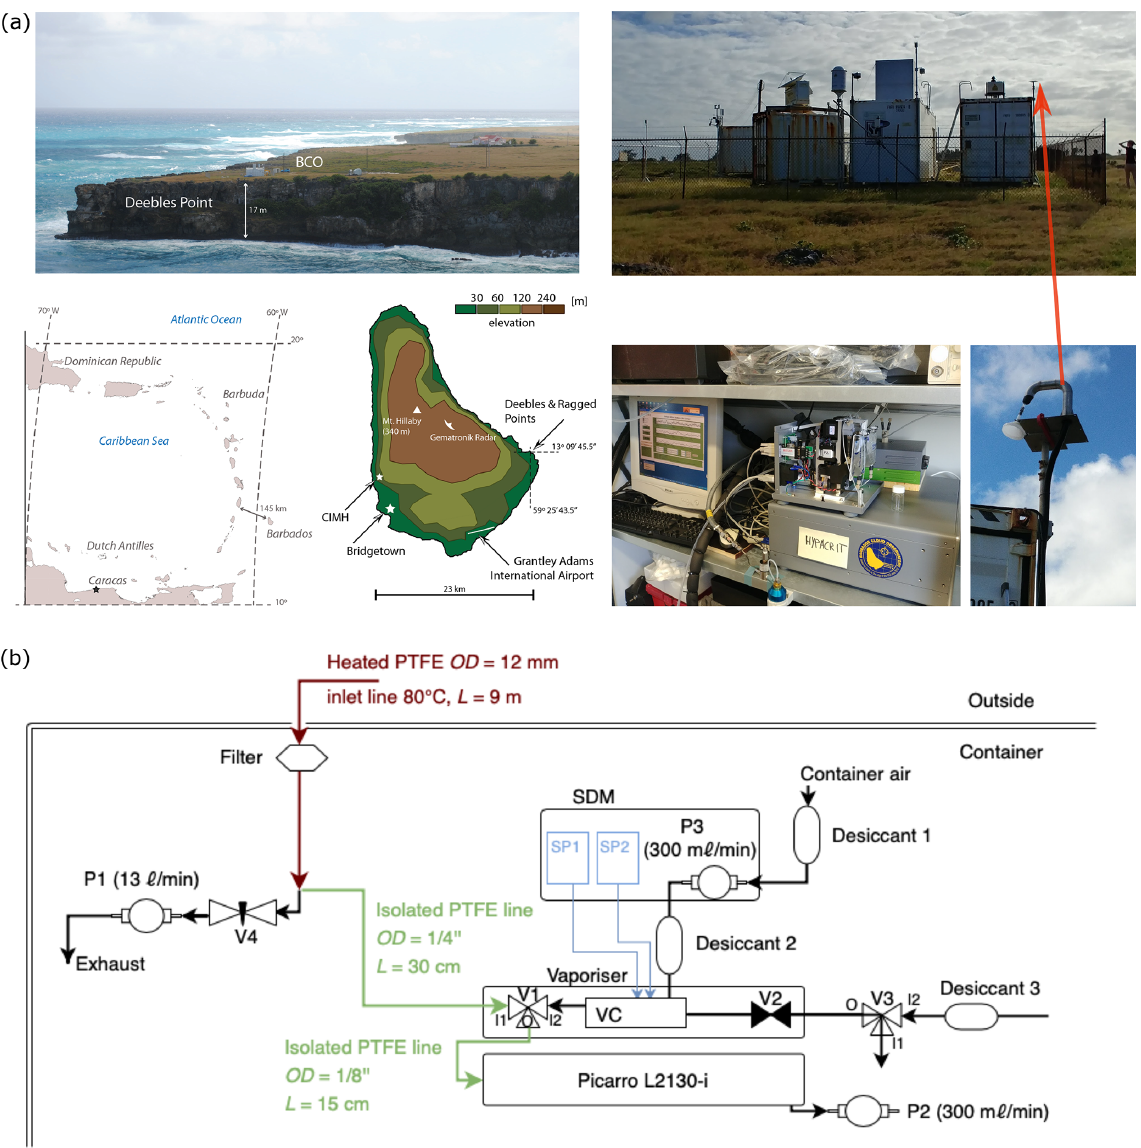
Figure 1. Set-up of the water vapour isotope measurement system at the Barbados Cloud Observatory, BCO. (a) The situation of the island of Barbados in the North Atlantic at the eastern boundary of the Caribbean Sea, together with a picture of the BCO at Deebles Point, one of the easternmost landmarks of the island (from Stevens et al., 2016). On the right, the measurement container with the inlet and the Picarro L2130 cavity ring-down spectrometer inside the container. (b) Gas flow schematic with air pumps (P1–3), high-precision liquid pumps for the injection of standard liquid water into the vaporiser (SP1–2), three-way valves (V1–3) and a flow restrictor (V4). SDM is the standard delivery module of Picarro; VC is the vaporiser chamber in which the calibration gas is